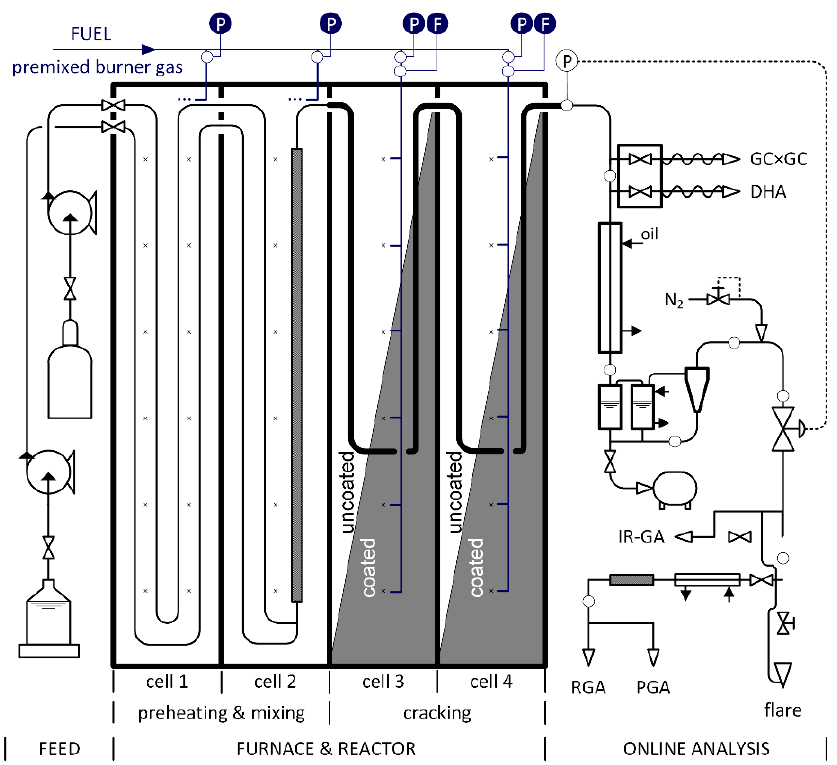
Figure 3. Visual representation of the steam cracking pilot unit at the Laboratory for Chemical Technology at Ghent University. The pilot unit id divided into a feed section, a furnace-reactor section, and an online analysis section [47].